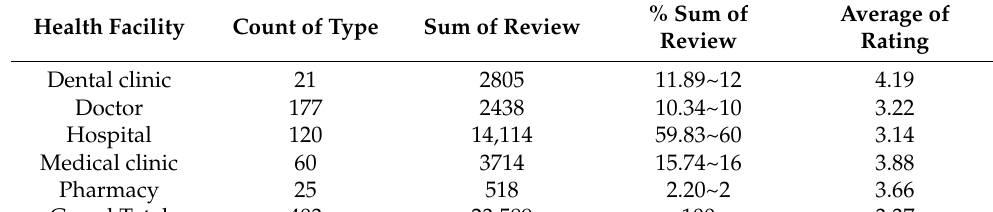
Table 7. Perceptions of Health Facility Services Based on POI Google.